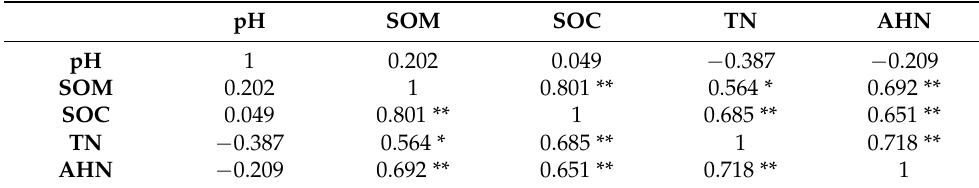
Table 3. Correlation analysis of pH, SOM, SOC, TN, and